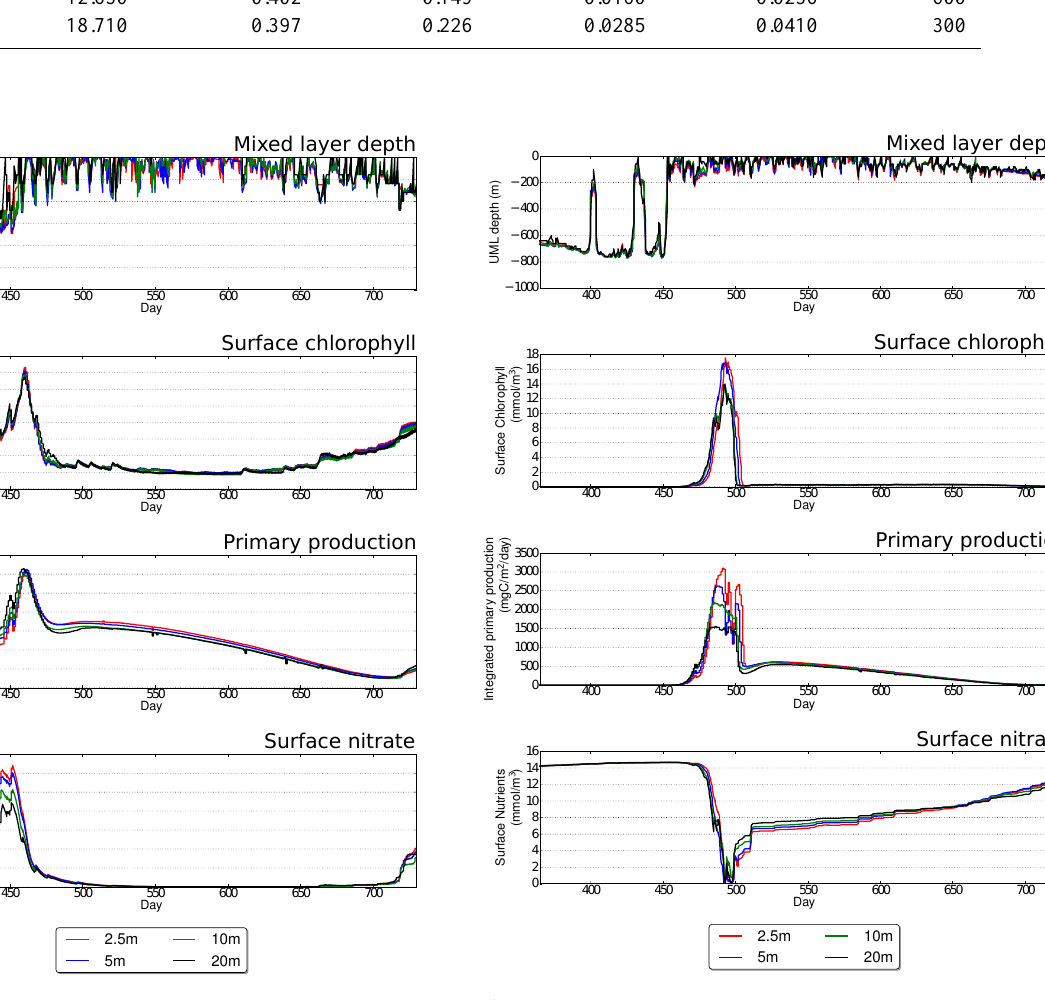
Fig. 7. Summary of simulated physical and biological behaviour at Bermuda using uniform meshes at a number of resolutions. From top to bottom, panels show MLD, surface chlorophyll, MLD aver- aged primary productivity and surface nutrients.